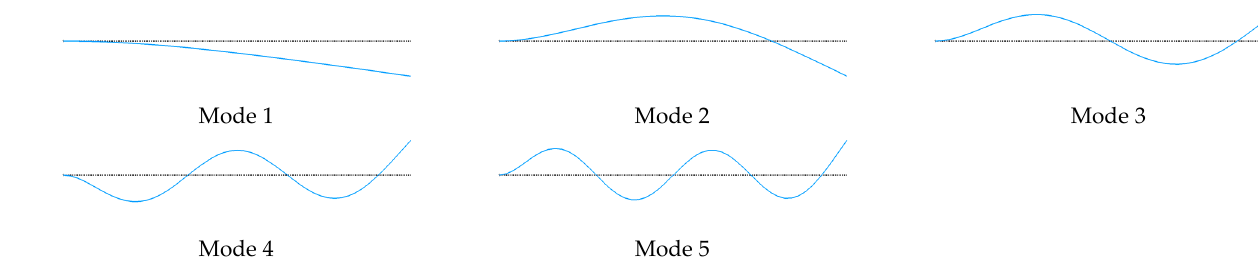
Figure A2. First five elastic modes with BC2: y ( 0 ) = y (cid:48) ( 0 ) = 0.